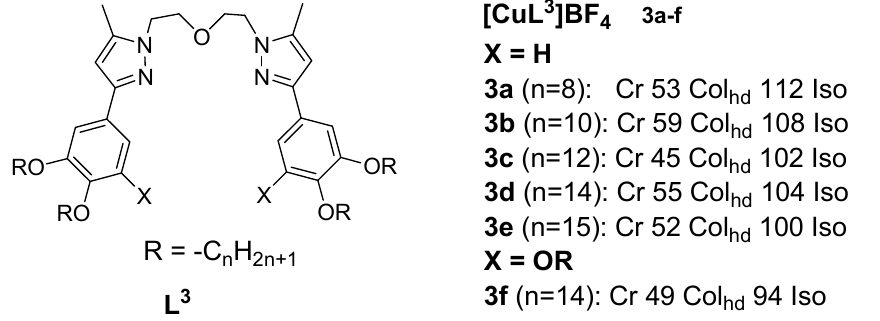
Figure 3. Copper(I) complexes with ether-type ligands. All temperatures are in °C